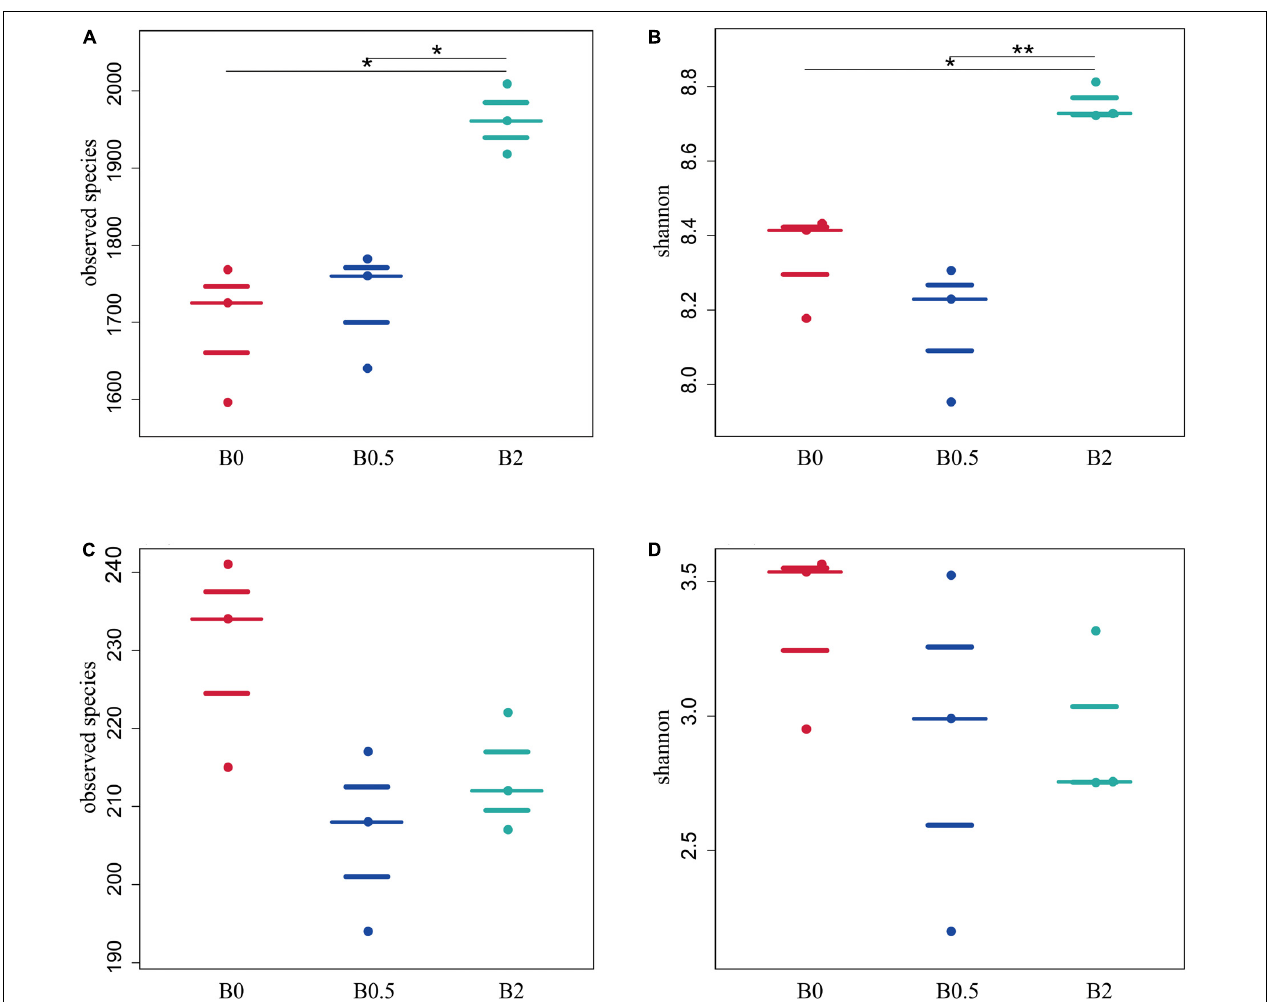
FIGURE 2 | The effects of biochar soil amendment on microbial diversity index. Panel (A,B) shows the effects of biochar amendment on the observed species, and Shannon diversity index of bacterial community, respectively; (C,D) shows the effects of biochar amendment on observed species, and Shannon diversity index of fungal community, respectively. Asterisks denote significant differences between different treatments as determined by the Tukey’s honestly significant difference test (* P < 0.05, ** P < 0.01; n =